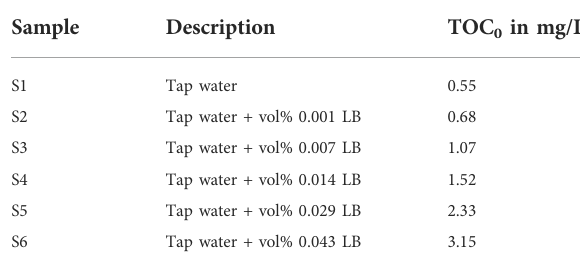
TABLE 1OverviewofTOC intap watersamples.The descriptionrefers to the amounts of LB medium in the tap water. The analyses were performed before the start of the real-time monitoring